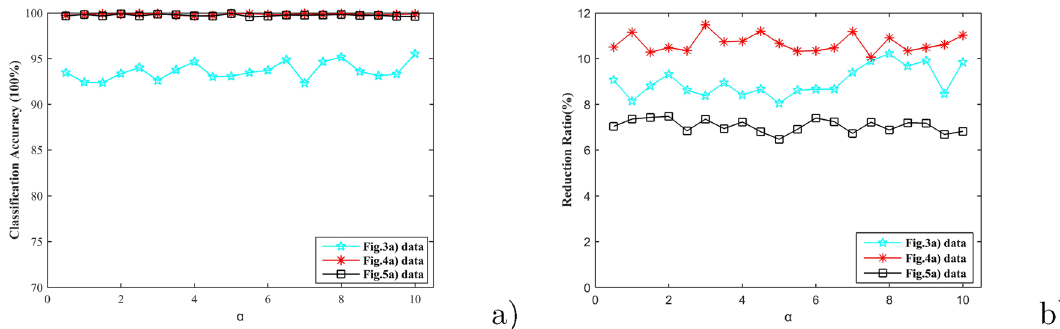
Figure 6. The results with different updating threshold value.